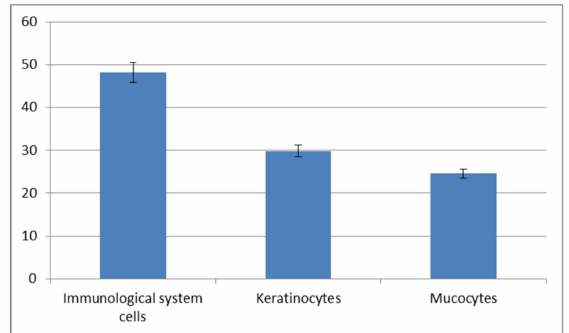
Figure 6. Cytological pictures of mucus: A. Mucus from the autumn-winter period; with a single immune cell (a macrophage, arrow). H-E 600x. B. Mucus from the spring-summer period; with lymphocytes (arrow). H-E 600x. C. Mucus from the autumn-winter period; with some neutrophils (circle). H-E 600x. D. Mucus from the spring-summer period; with visible interconnected epithelial cells (arrow). H-E 600x. E. Mucus from the autumn-winter period; with macrophages (circle) and exfoliated epithelium cells (arrow). H-E 600x. F. With a keratinocyte (arrow) and a migrating phagocyte (white arrow). H-E 600x.